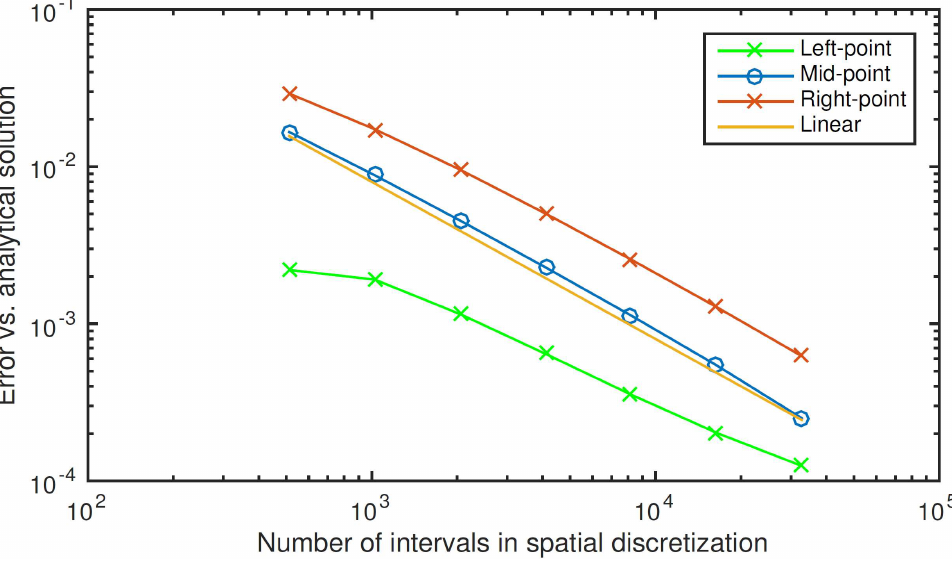
Figure 2. Convergence using different S for approximating the convolution term. We note that for mid-point and right − point schemes, the convergence is clearly linear. For the left-point scheme, it appears to be sub − linear.